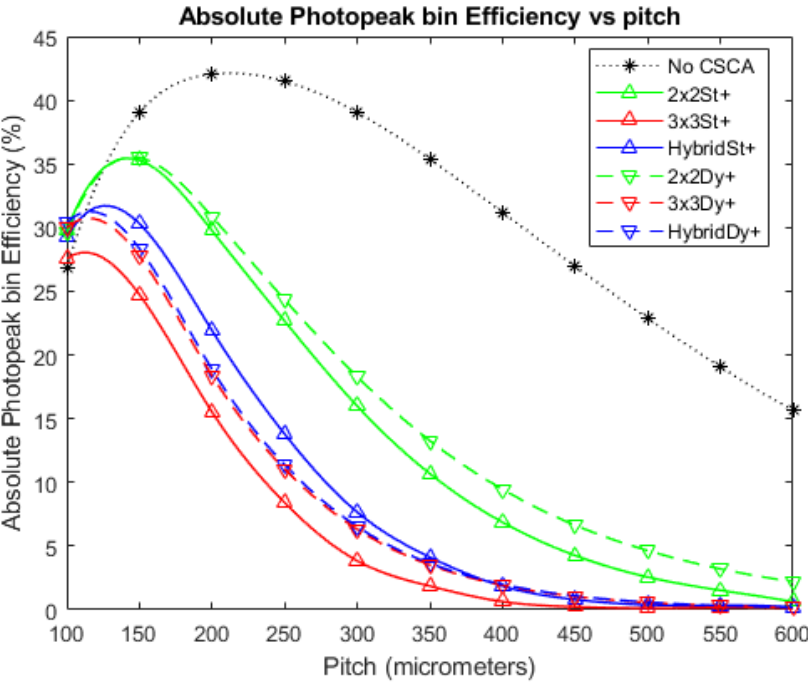
Figure 13. A plot of BSE versus pixel pitch at an incident photon flux of 10 8 photons mm −2 s −1 . The dynamic Hybrid and dynamic 3 × 3 CSCAs perform exceptionally closely according to this metric, resulting in significant overlap. The case where no CSCA is applied is also shown as a reference.